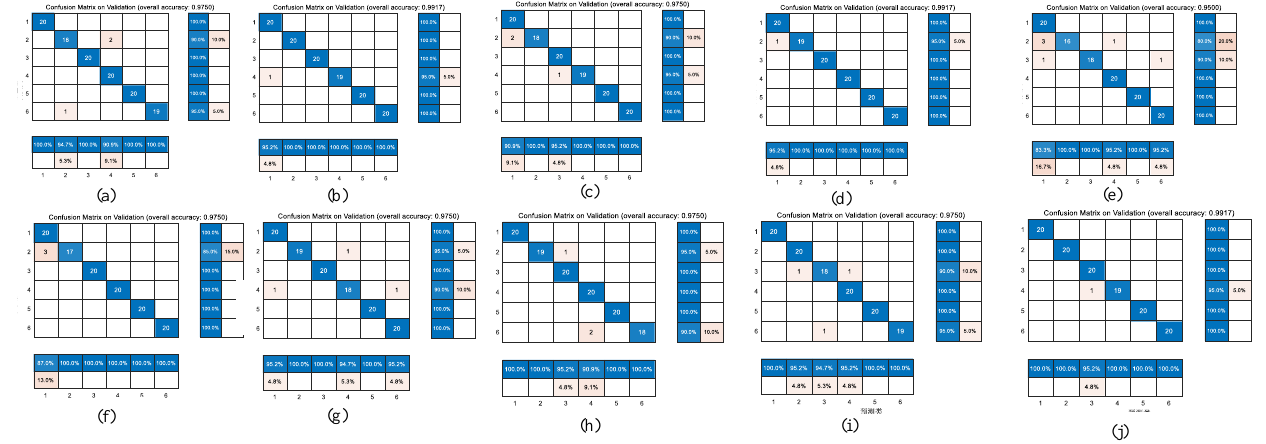
Figure 6. 10-fold cross validation of confusion matrix for the GoogleNet model on augmentation database. The accuracy of each fold is: ( a ):0.98; ( b ):0.99; ( c ):0.98; ( d ):0.99; ( e ):0.95; ( f ):0.98; ( g ):0.98;